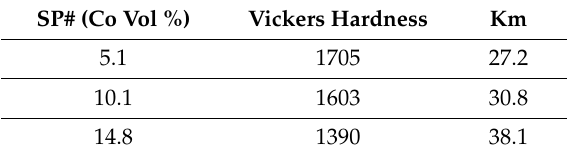
Table 1. Data from Exner et al. [10] on Co Vol %; Vickers hardness and toughness.